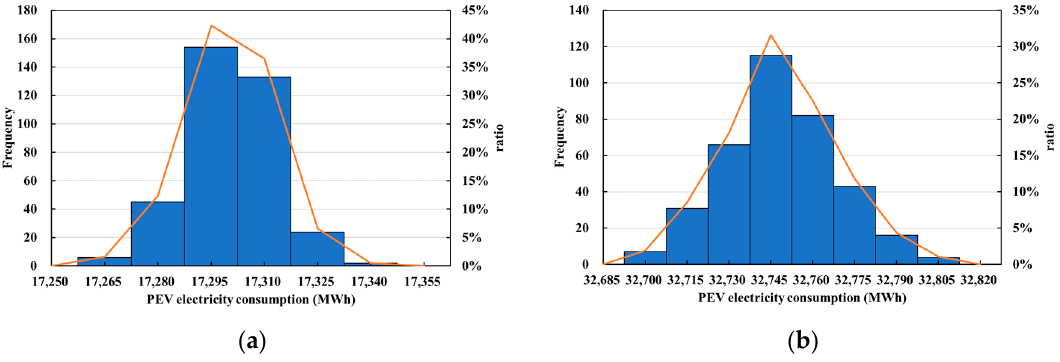
Figure 13. Distribution of daily electricity consumption of all PEVs in Korean power system; ( a ) PEV 3 m; ( b ) PEV 5 m.